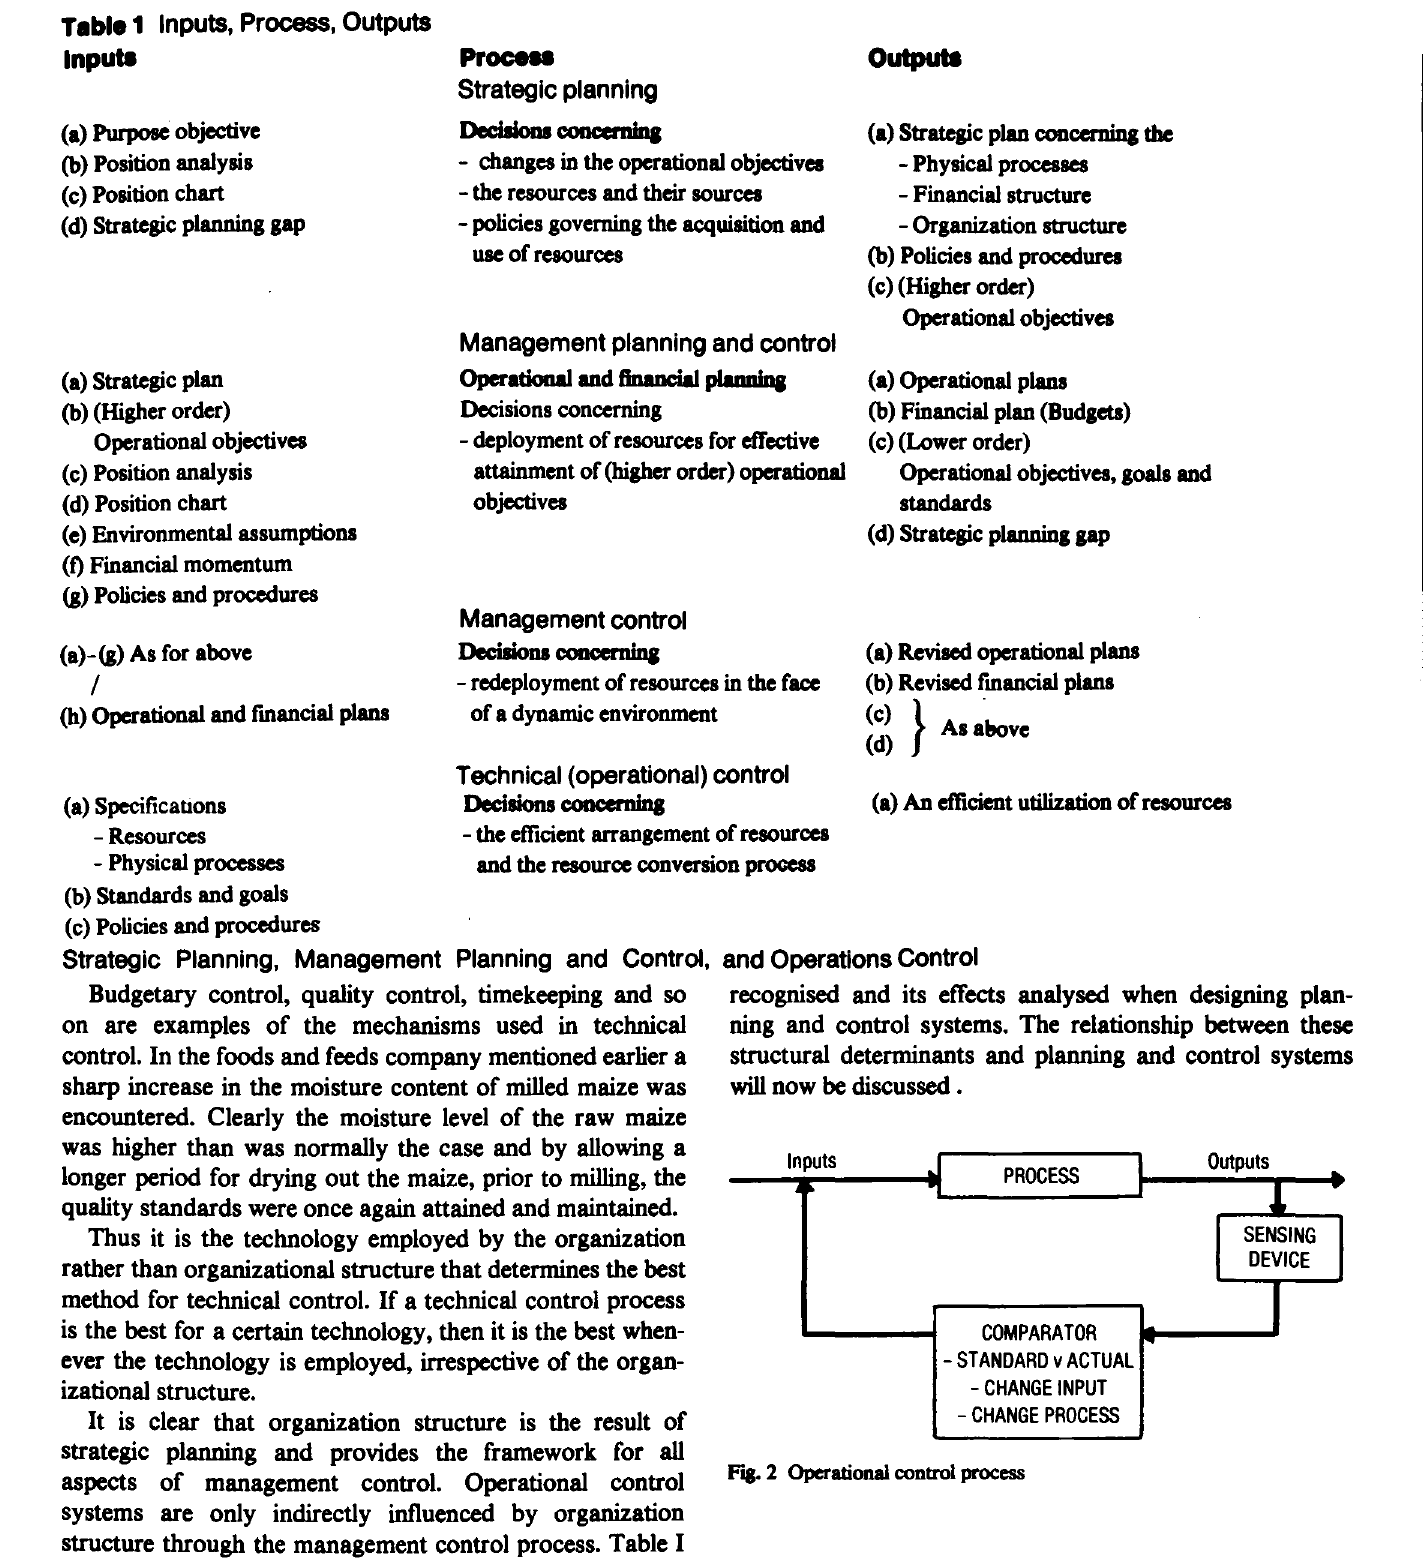
Table 1 Inputs, Process, Outputs lnputa